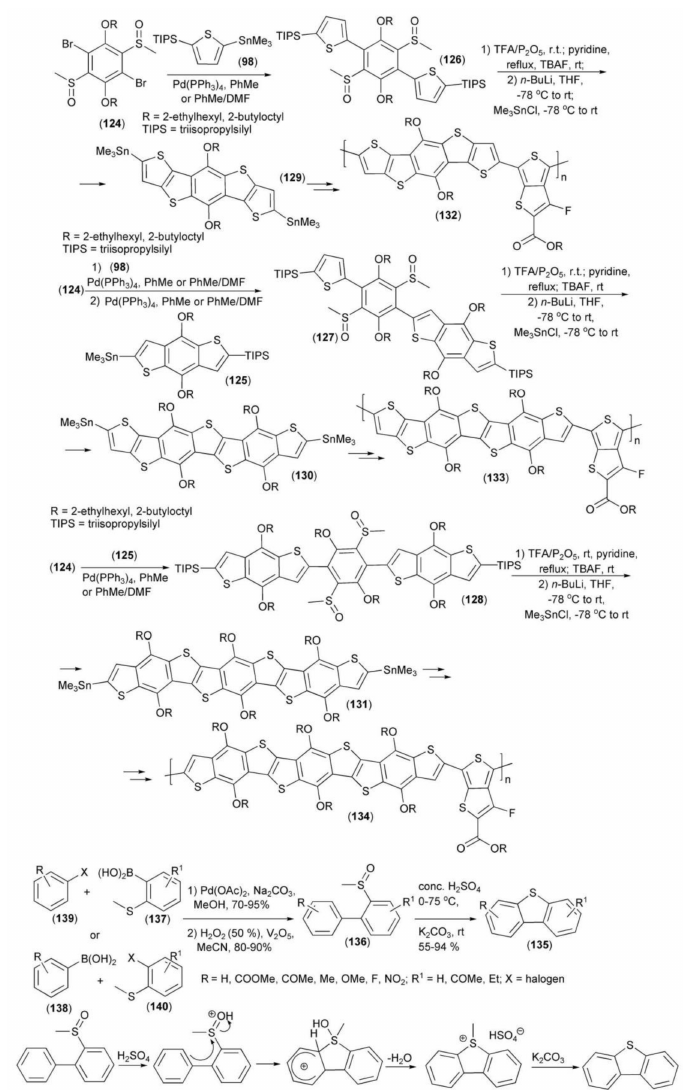
(1:1.5, wt ratio) / Ca / Al. Polymers ( 132–134 ) revealed a photoconversion e ffi ciency in the range